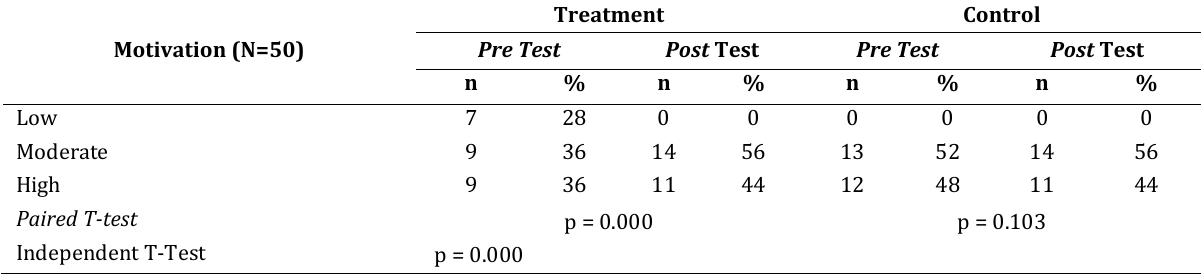
Table 3. Motivation Results Before and After being Given Psychoeducation Therapy in the Treatment and Control Groups of Breast Cancer Patients (Ca Mammae)